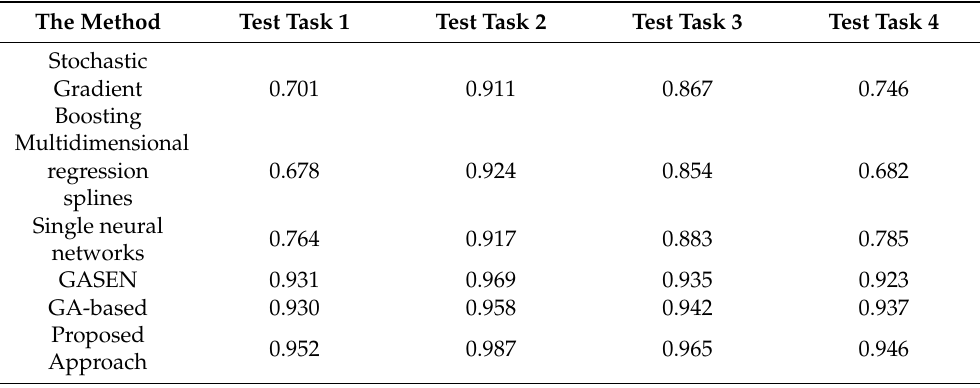
Table 3. Data on the results of the study of methods on test problems with additive noise 5%.